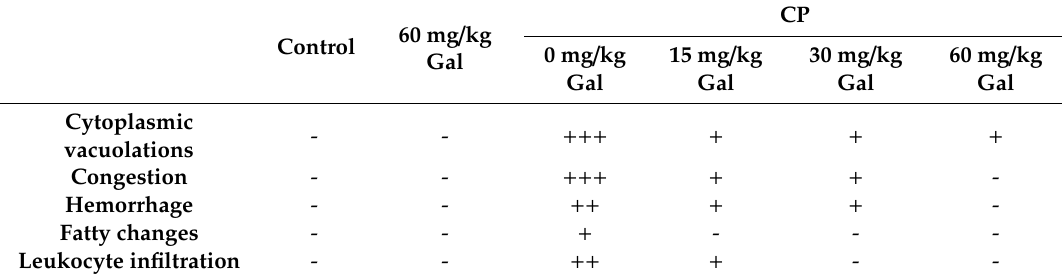
Table 2. Histopathological alterations in liver of control and CP-induced rats treated with galangin (Gal).